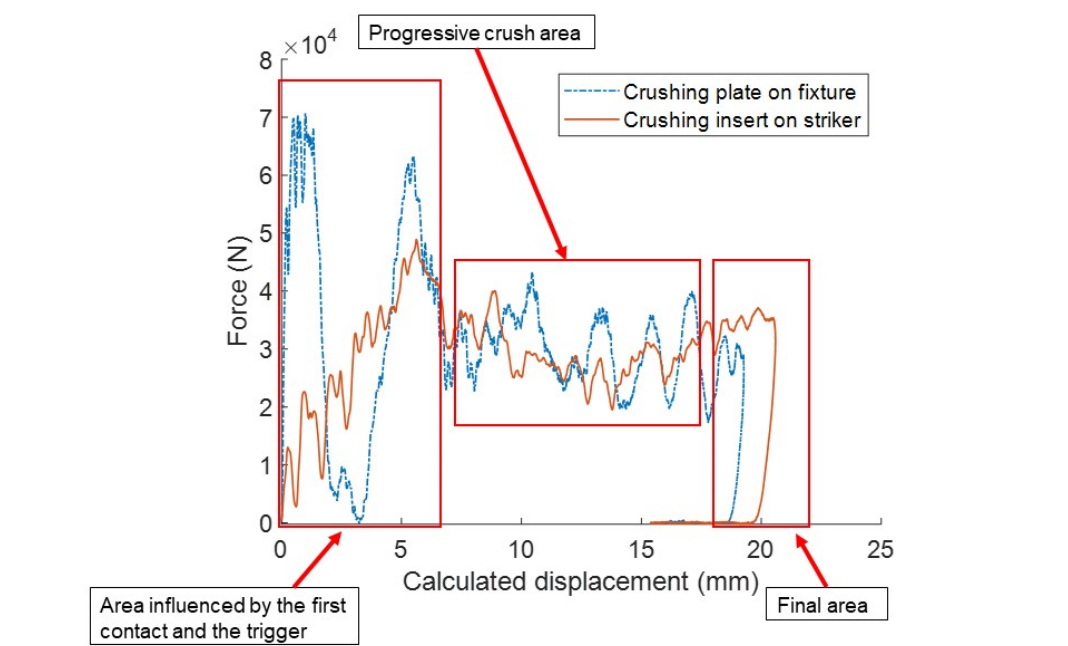
Figure 3: Comparison between results obtained in the configuration with crushing plate on the fixture (blue dash-dot curve) and with crush insert on the striker (red solid curve) during a test with impact energy of 600 J and dropped mass of 60.2